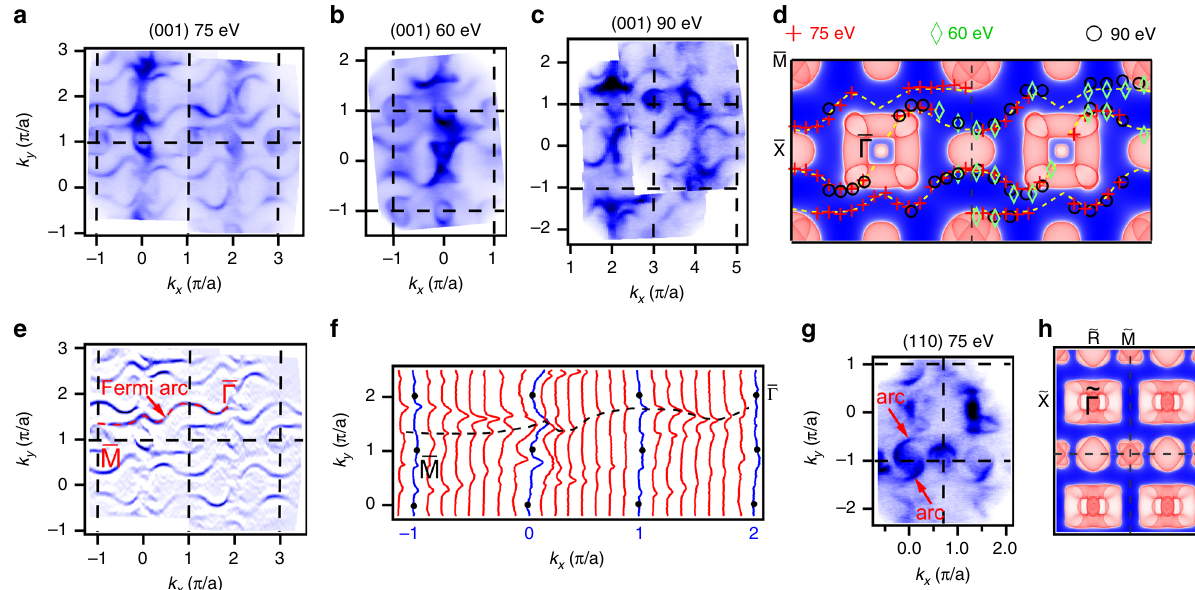
Fig. 3 (001) and (110) surface states of RhSn. a – c ARPES intensity maps at E F measured on the (001) surface at h ν = 75 eV ( a ), 60 eV ( b ) and 90 eV ( c ). d Projected bulk FSs without SOC on the (001) surface. The yellow dashed curves are a guide to the surface Fermi arcs. The red crosses, green diamonds and black circles are extracted from peak positions of momentum distribution curves (MDCs) of the ARPES data in a , b and c , respectively. e Curvature intensity map of the ARPES data in a . The red dashed curve indicates one representative surface Fermi arc extending from (cid:1) Γ to (cid:1) M . f MDCs of the ARPES data in a . The blue curves indicate the MDCs along the high-symmetry lines. The black dots mark the high-symmetry points. The back dashed curve is a guide to the peak positions of the MDCs. g ARPES intensity map at E F measured on the (110) surface at h ν = 75 eV. h Projected bulk FSs without SOC on the (110)